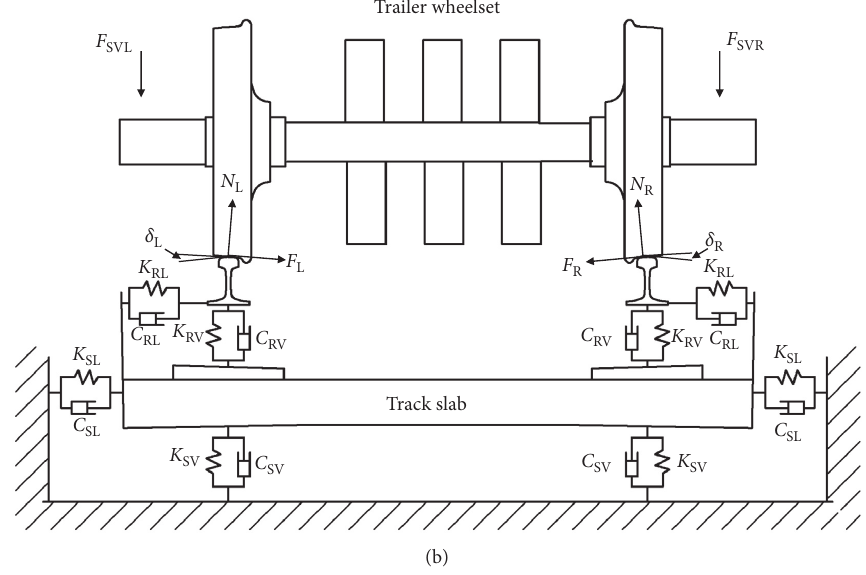
Figure 3: Contact geometry models of wheelset-track system: (a) the power wheelset, (b) the trailer